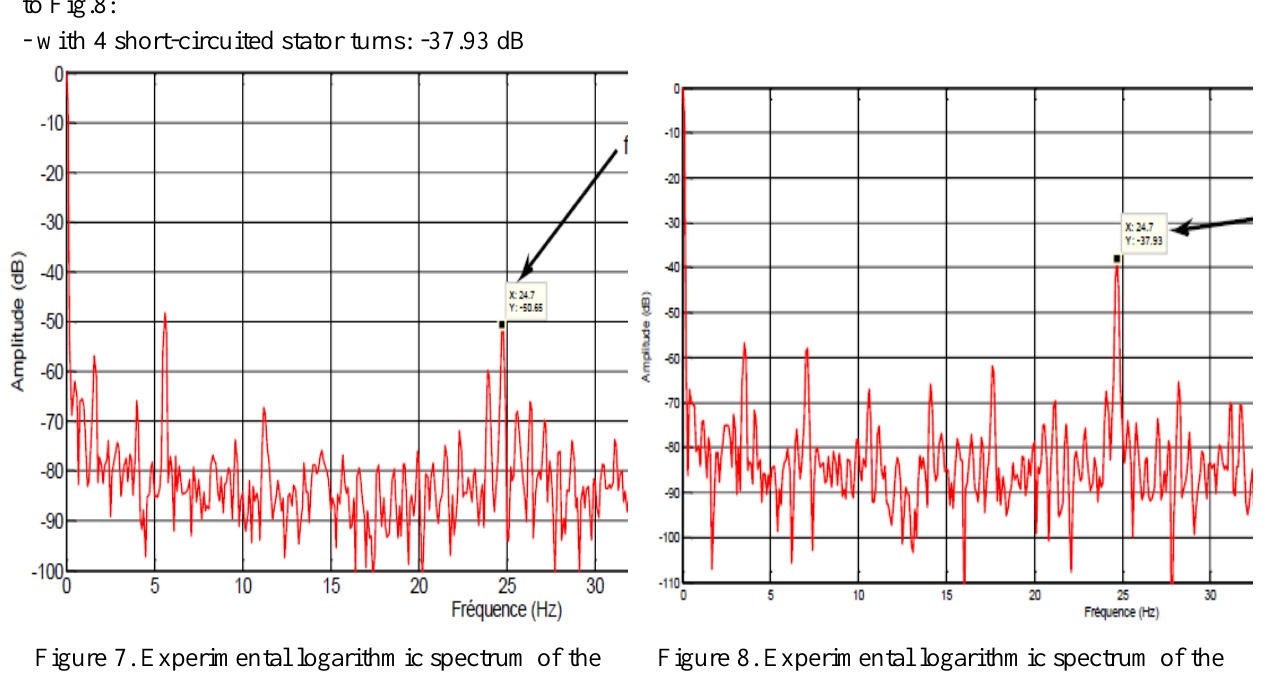
Figure 7. Experimental logarithmic spectrum of the Figure 8. Experimental logarithmic spectrum of the 𝐏𝐕𝐒𝐌𝐏 − 𝐇 of a motor with 4 short-circuited stator 𝐏𝐕𝐒𝐌𝐏 − 𝐇 of a motor with 4 short-circuited stator turns at low load turns at full